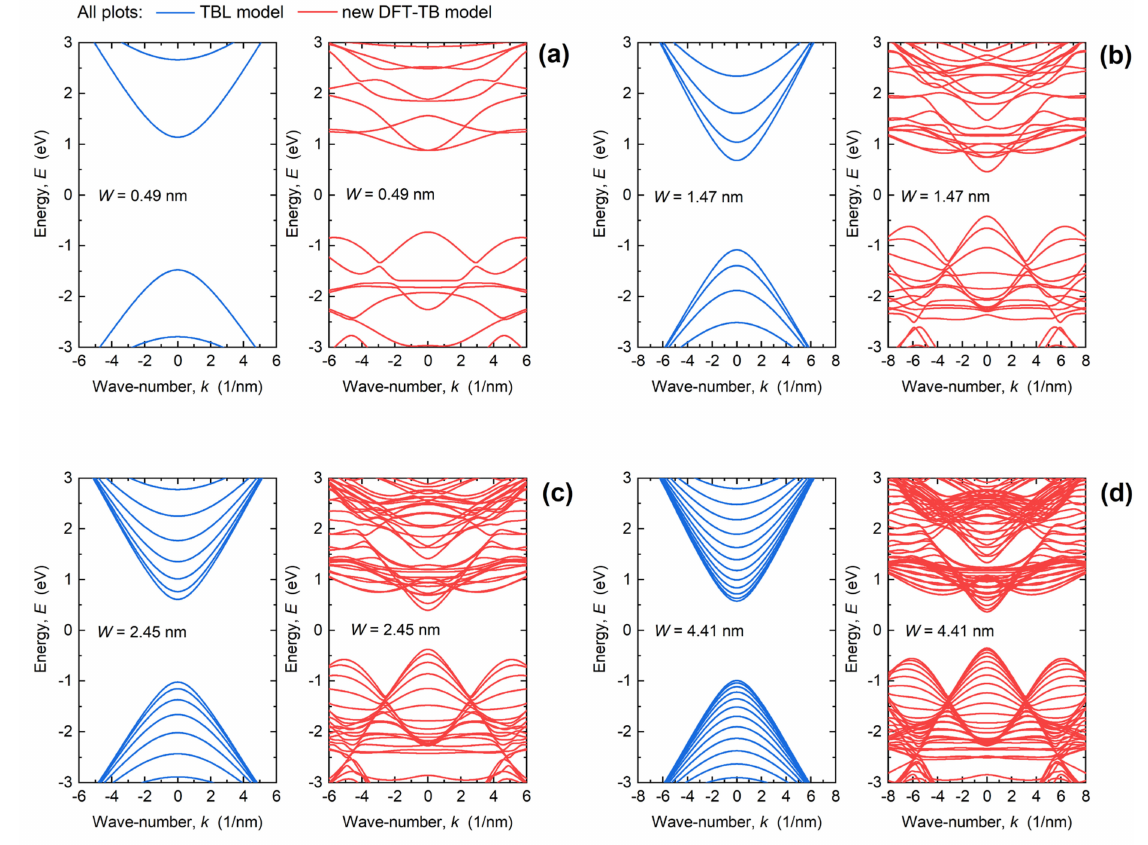
Figure 2. Comparison of dispersions obtained by the DFT-TB (panels on the right) and TBL (panels on the left) models for PNR widths of ( a ) 0.49 nm, ( b ) 1.47 nm, ( c ) 2.45 nm, and ( d ) 4.41